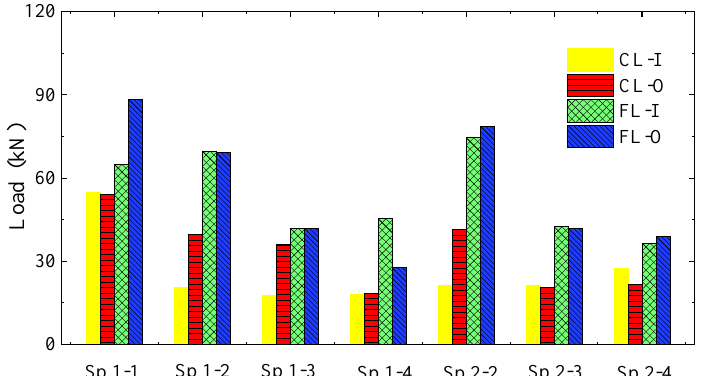
Figure 12. Crack load and failure load with different methods. Note: CL-O is the load corresponding to the first cracking, as based on observation; FL- O is the load corresponding to the formation of a complete cracking pattern, as based on observation; CL-I is the cracking load based on the strain analysis; and FL-I is the failure load based on the strain analysis.